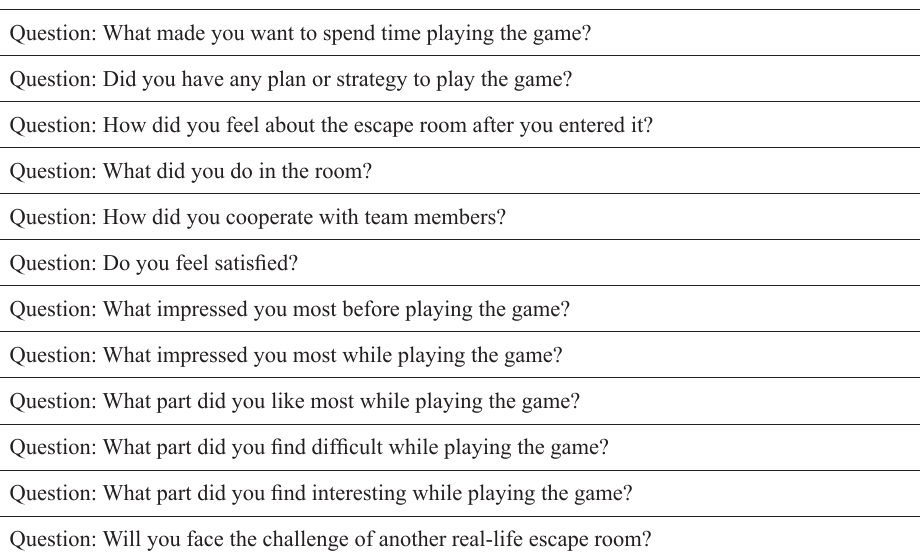
Table 4. Select questions used in the group